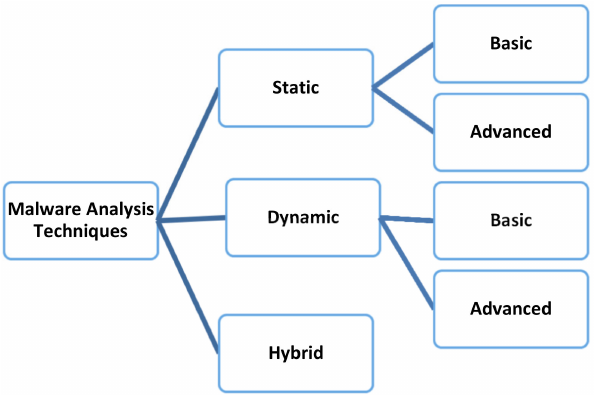
Figure A1. Malware Analysis